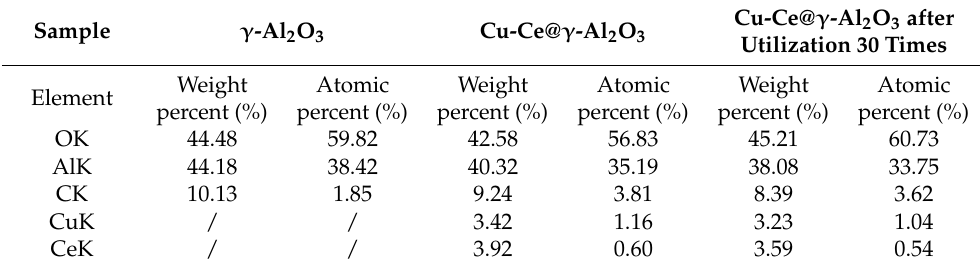
Table 2. EDS characterization of Cu-Ce@ γ -Al 2 O 3 catalyst.